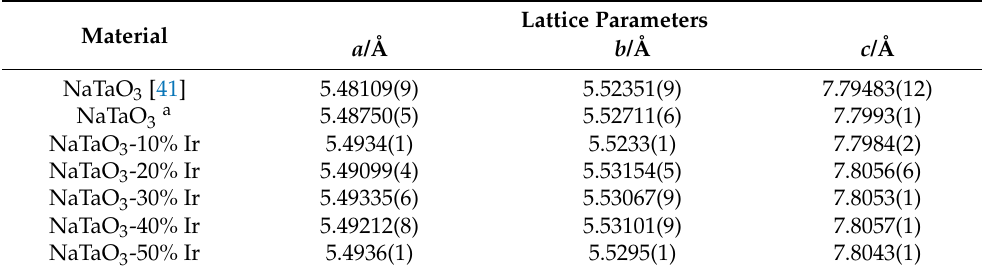
Table 1. Refined lattice parameters of substituted sodium tantalates from analysis of powder XRD data. The intended level of Ir substitution is indicated.